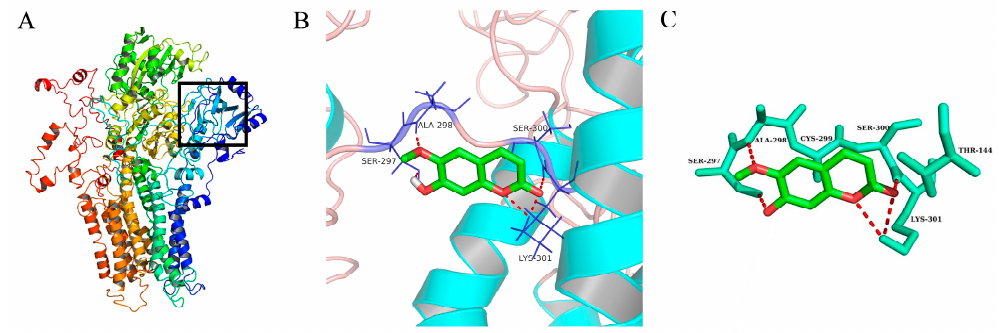
Figure 8. ( A ) Binding pocket of TcPMCA1 was indicated by the black frame; ( B ) best conformation of scopoletin docked to binding pocket of TcPMCA1 ; ( C ) cartoon representation of residues involved in the binding of scopoletin to TcPMCA1 . The black box represents the binding cavity. Short, red dashed lines represent hydrogen bonds. Red regions represent oxygen atoms of scopoletin; green regions represent the carbon atoms of scopoletin; the others represent the amino acid residue of the protein. The 30 coumarin derivatives (Table 1) were also subjected to molecular docking calculations.